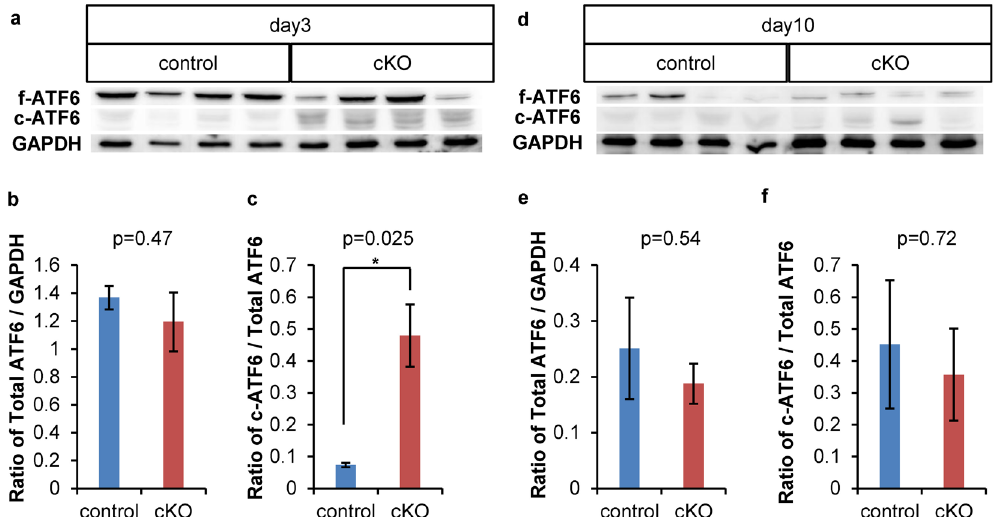
Figure 4. Cleavage of ATF6 was upregulated in Ptf1a cKO mice on day 3 but recovered by day 10. ( a ) Western blotting of control and Ptf1a cKO mice on day 3. ( b ) Comparison of the ratio of total ATF6/GAPDH expression in control and Ptf1a cKO mice on day 3. ( c ) Comparison of the ratio of cleaved ATF6/total ATF6 expression in control and Ptf1a cKO mice on day 3. ( d ) Western blotting of control and Ptf1a cKO mice on day 10. ( e ) Comparison of the ratio of total ATF6/GAPDH expression in control and Ptf1a cKO mice on day 10. ( f ) Comparison of the ratio of cleaved ATF6/total ATF6 expression in control and Ptf1a cKO mice on day 10. f-ATF6: full length ATF6, c-ATF6: cleaved ATF6. control, n = 4; Ptf1a cKO, n = 4. * P < 0.05. The original, unprocessed scans of the blots are shown in Supplementary Fig. S5.